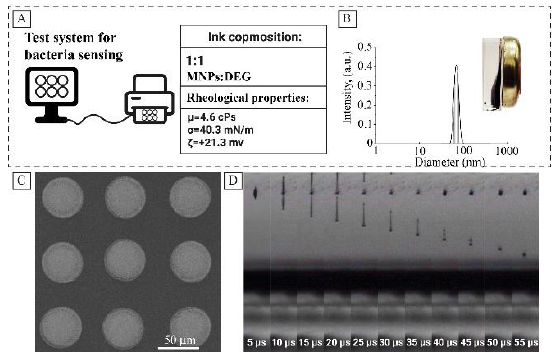
Figure 5. Inkjet printing ink based on magnetite hydrosol, basic rheological parameters ( A ); hydrodynamic radius of magnetite particles ( B ); SEM image of magnetite droplets on a roll substrate ( C ); life cycle of the droplet after leaving the nozzle ( D ).